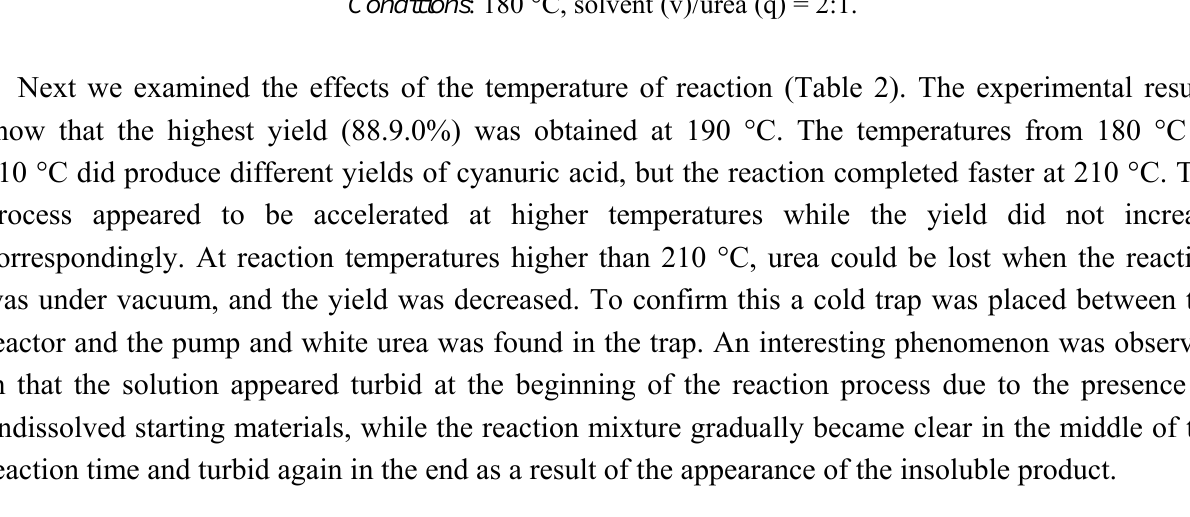
Table 2. Effect of reaction temperature on experimental